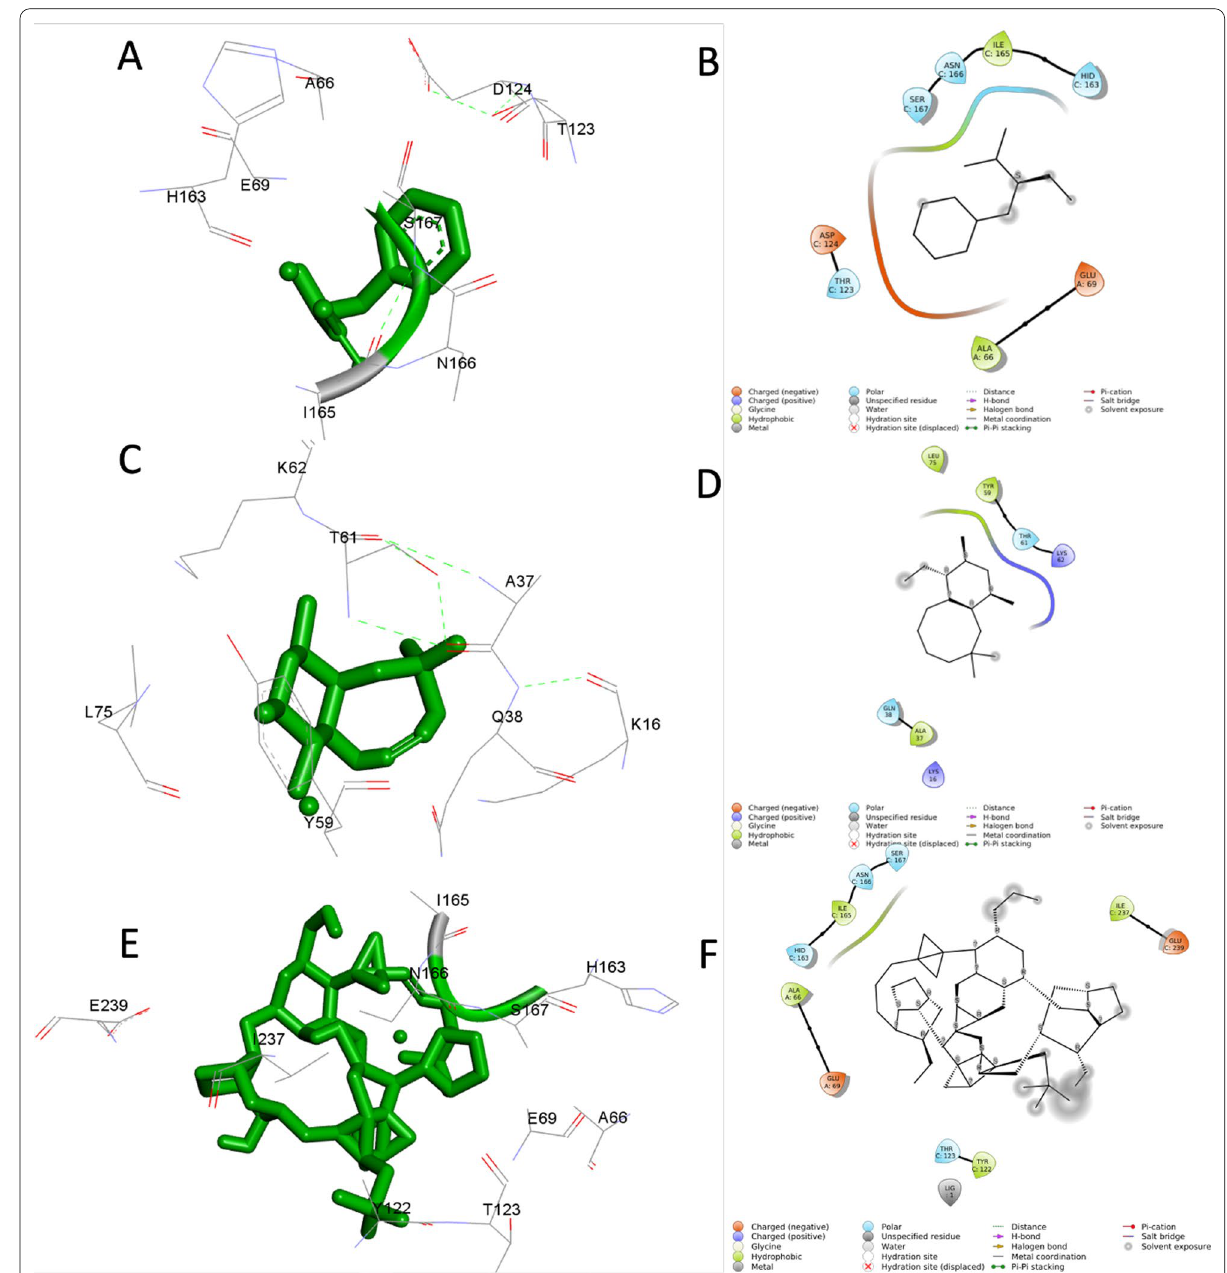
Fig. 5 Molecular interactions of S. typhi OmpF with 3-phenyllactate 3D interaction ( a ) and 2D interaction ( b ); Fucoidan 3D interaction ( c ) and 2D interaction ( d ); κ-carrageenan 3D interaction ( e ) and 2D interaction ( f